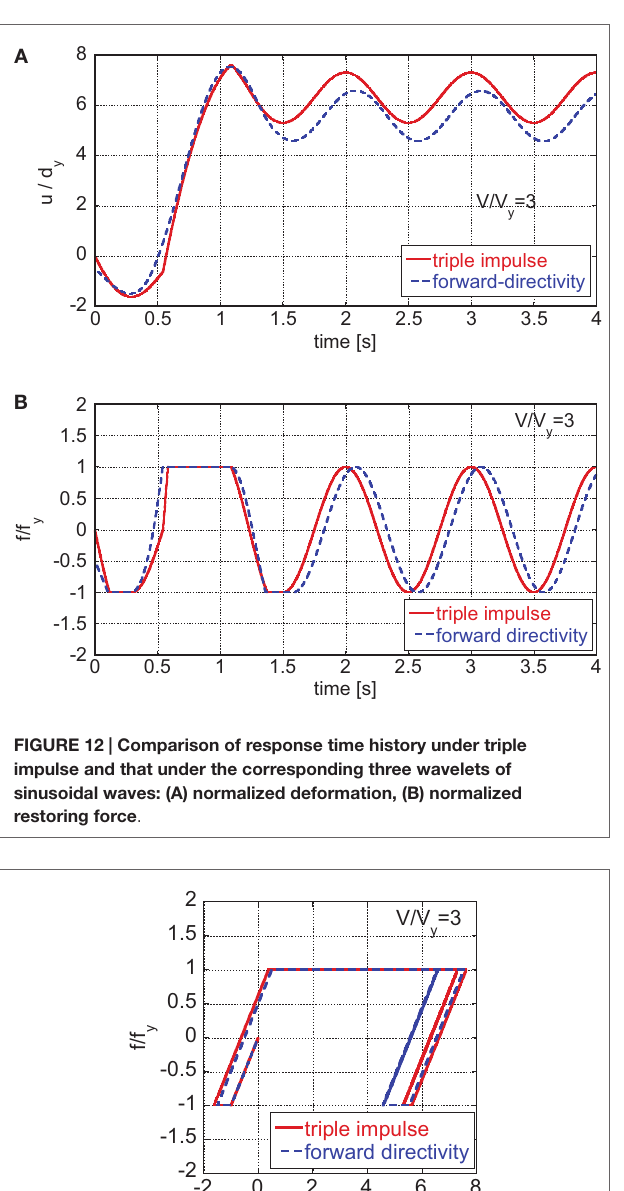
FigUre 13 | comparison of restoring force characteristic under triple impulse and that under the corresponding three wavelets of sinusoidal waves .